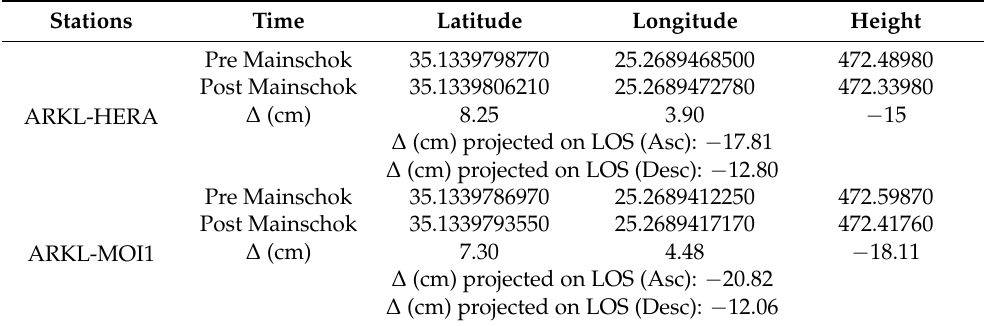
Table 3. Co-seismic Offset of GNSS PPK processing.